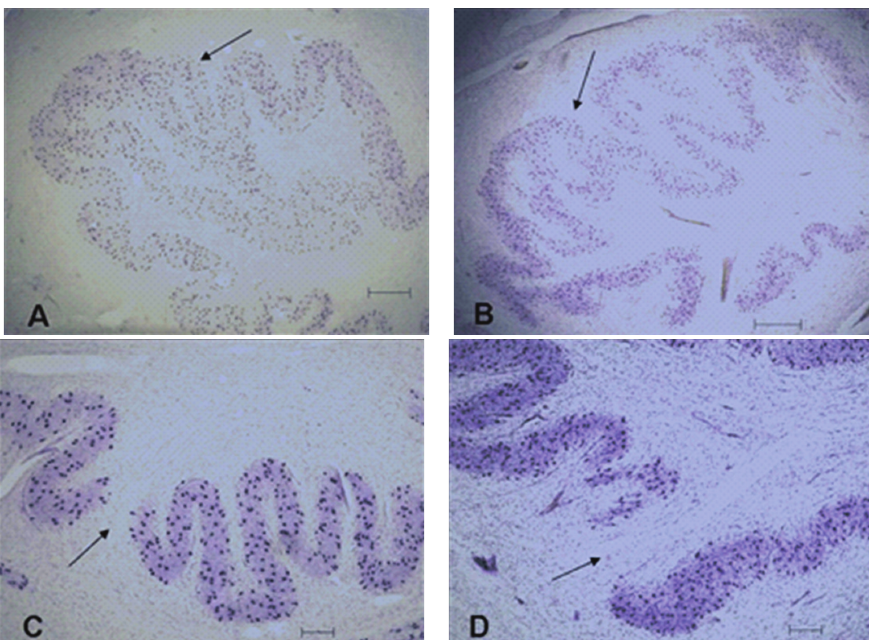
F 4: Photomicrographs showing similar altered formations of the principle olive in the autistic (A and C) and control brains (B and D). A and B show what appear to be reduplications (arrows) and C and D show examples of a gap in the ribbon (arrows) of the principle olive which may be caused by perforating